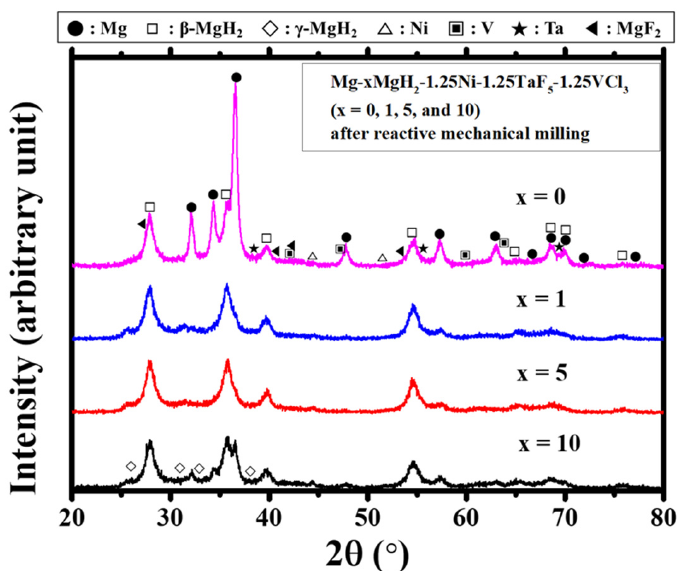
Figure 6. XRD patterns of Mg-xMgH 2 -1.25Ni-1.25TaF 5 -1.25VCl 3 (x = 0, 1, 5, and 10) after reactive mechanical milling.